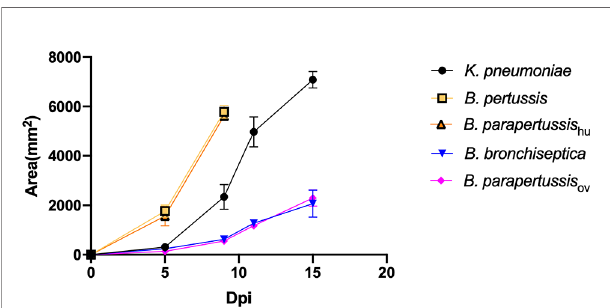
FIGURE 2 | D. discoideum ef fi ciently feed on human-restricted Bordetella species, B. pertussis and B. parapertussis human strain. The plaque areas formed on the lawn of Bordetella species were measured at various days post inoculation (Dpi). The plaques formed on the lawn of B. pertussis and B. parapertussis hu covered the entire plate before d15pi, therefore the last data point was d9pi. Average and standard error of three biological replicates are